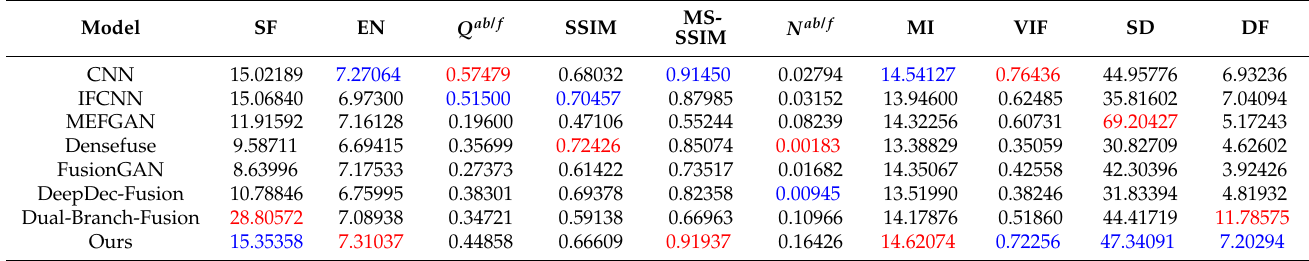
Table 3. Objectively evaluate the classical and latest fusion algorithms.